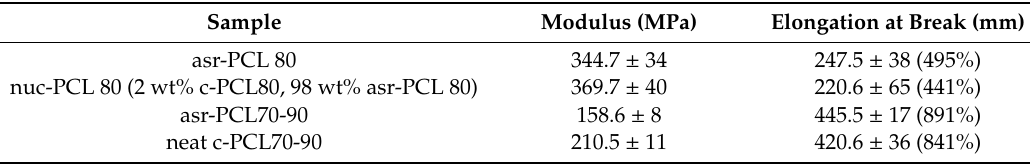
Table 1. Tensile test results for single layer films. Reproduced with permission from [43]. Copyright 2015 American Chemical